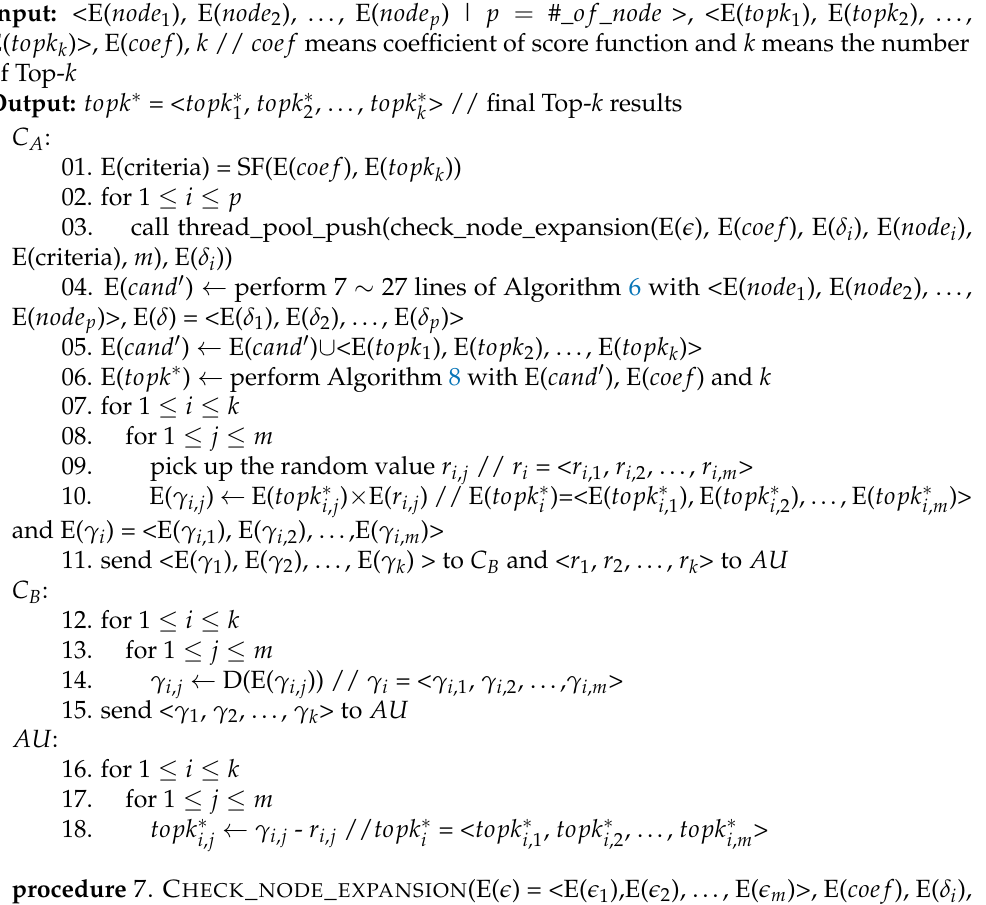
Algorithm 9 Parallel Top- k result refinement